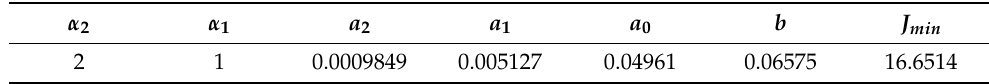
Table 3. Parameter identification results of integer order